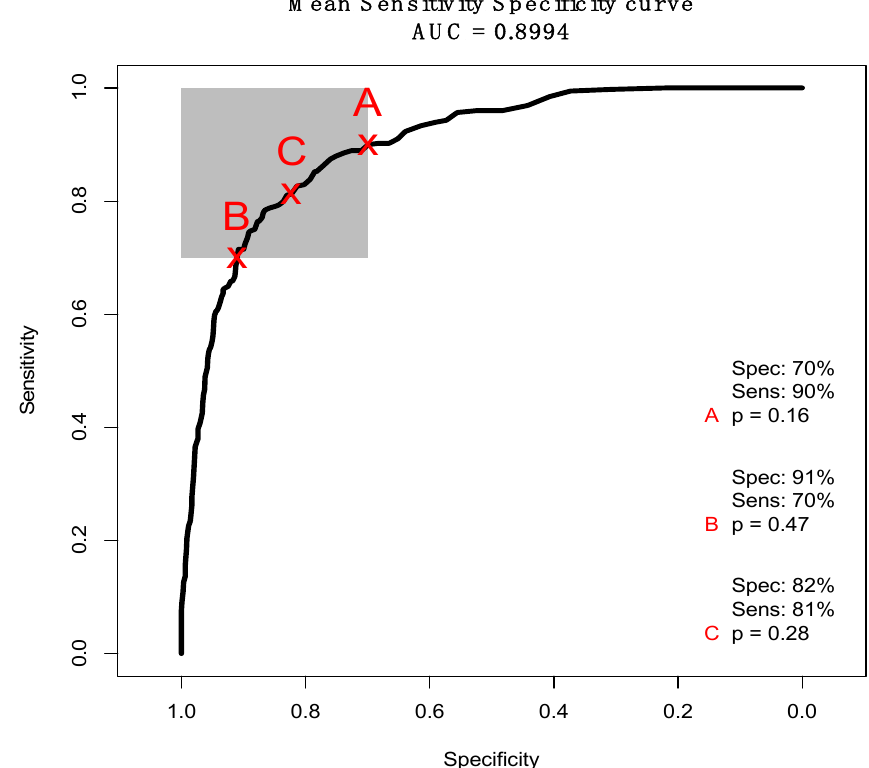
Figure 8. Mean receiver operator characteristic (ROC) curve displaying the trade-off between sensitivity and specificity for 51 resampled linear discriminant analysis (LDA) classifiers. The grey square is a target region of at least 70% for both sensitivity and specificity. The ‘x’ labels are the points on the curve that maximise sensitivity (A), specificity (B) and balance the two (C) whilst remaining in the target area, and ‘p’ represents the probability thresholds at those points on the curve.